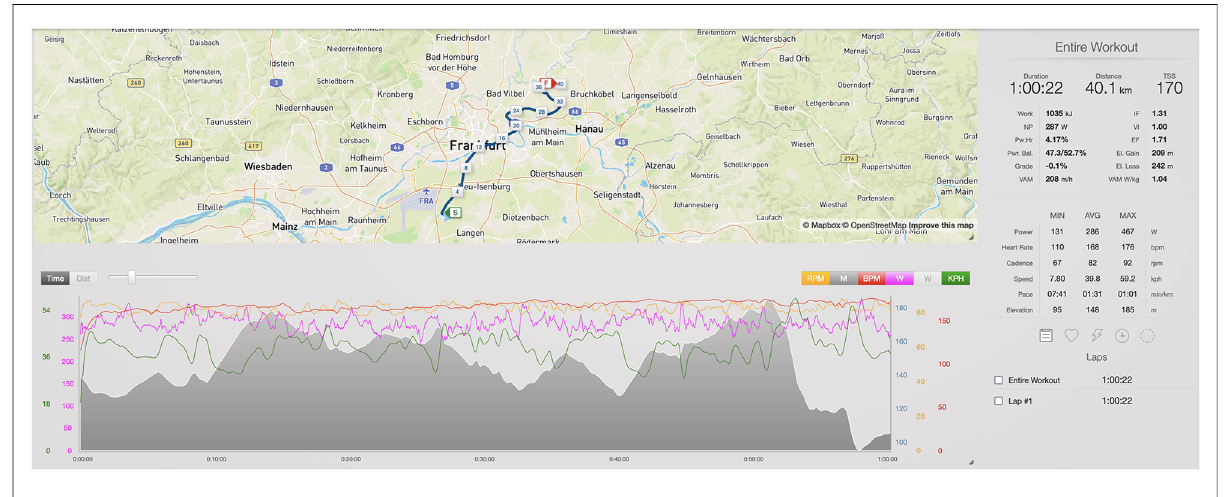
FIGURE 2 Cycling route (extracted from TrainingsPeaks, Peaksware, United States of